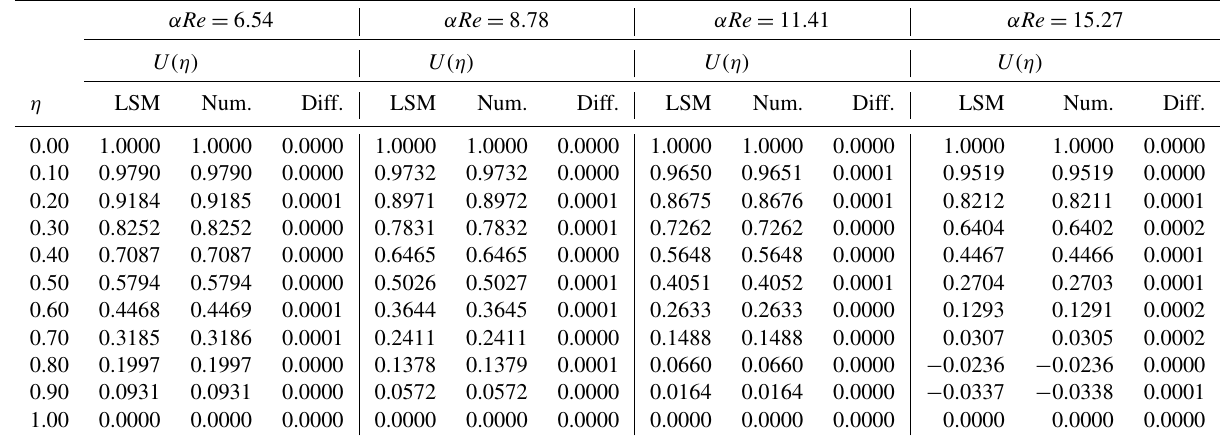
Table 1. The dimensionless velocity distribution comparison for the LSM and the numerical method at Ha = 1, α = 2 . 5 ◦ , and ( α Re ) sep . = 11 .